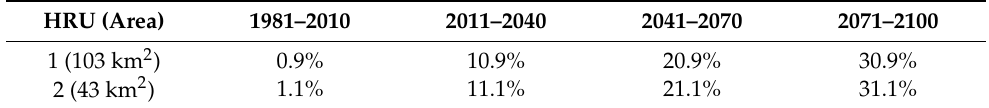
Table 5. Evolution in impervious area in the LULCCC